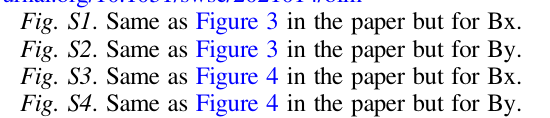
Fig. S1 . Same as Figure 3 in the paper but for Bx. Fig. S2 . Same as Figure 3 in the paper but for By. Fig. S3 . Same as Figure 4 in the paper but for Bx. Fig. S4 . Same as Figure 4 in the paper but for